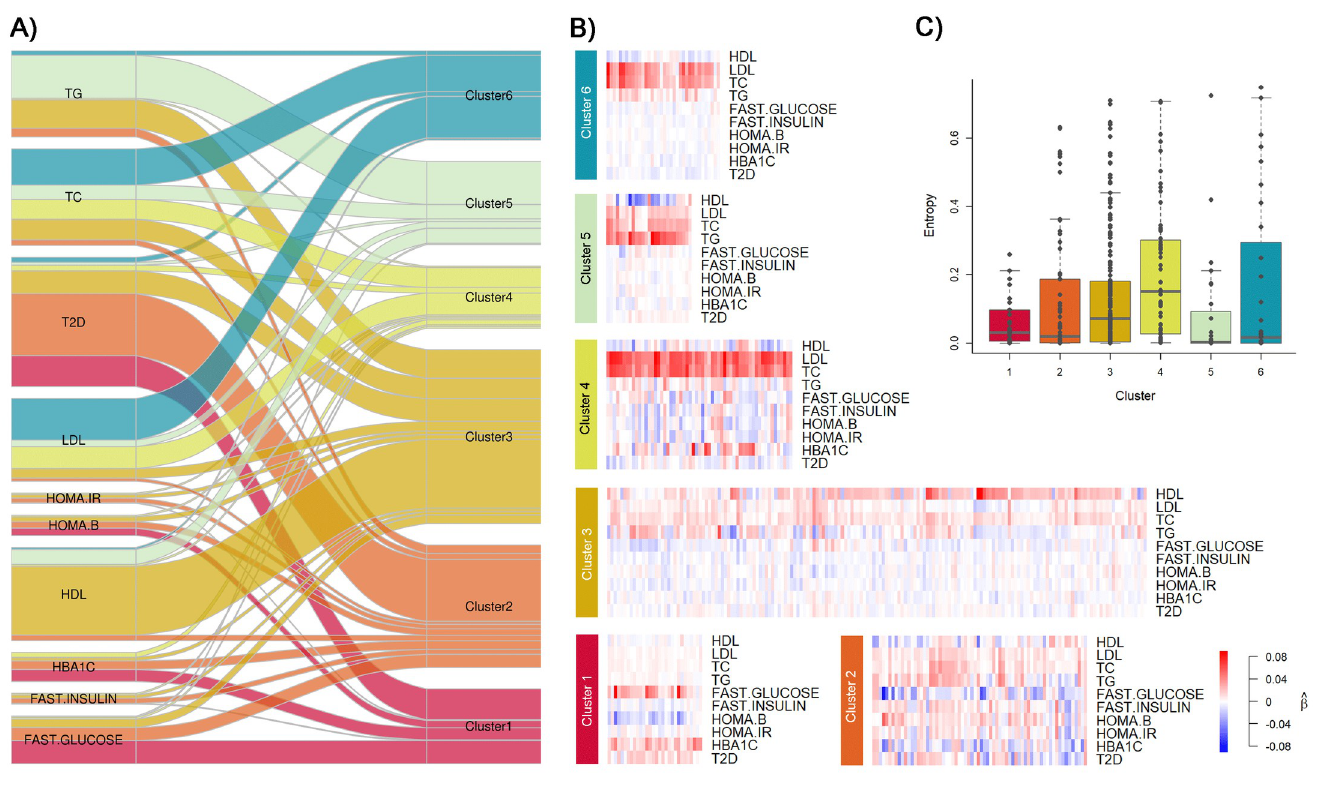
Fig 4. Multitrait genetic association clusters for the Metabolism set. The panels summarize the clustering of the 392 independent SNPs selected from the Metabolism set analysis. The set includes 10 phenotypes: triglyceride (TG), total cholesterol (TC), type 2 diabetes (T2D), low-density lipoprotein cholesterol (LDL-C), high-density lipoprotein cholesterol (HDL-C), glycated hemoglobin (HbA1c), Homeostasis model assessment of β -cell function (HOMA-B), homeostasis model assessment of insulin resistance (HOMA-IR), fasting insulin, and fasting glucose. The alluvial plot in panel A ) represents the decomposition of univariate genetic association and its rewiring to the six inferred clusters. The flow widths represent the proportion of phenotype’s variance explained by the subset of SNPs assigned to each specific cluster, relative to the total genetic variance explained by all 392 SNPs. For example, SNPs from cluster 6 capture approximatively 41.7% and 54.6% of that genetic variance for TC and LDL, respectively. For clarity, flows explaining less than 0.1% of the variance are not represented. Panel B ) shows the heatmap of normalized beta coefficients per phenotype within each cluster. Each column is a SNP, with blue and red colors indicating negative and positive beta, respectively. Coded alleles have been defined according to the per cluster first principal component. The boxplots in panel C ) shows the distribution per cluster of SNP’s entropy, an indicator of the fitness of the SNP-cluster assignment. SNPs perfectly assigned are expected to have entropy close to zero.